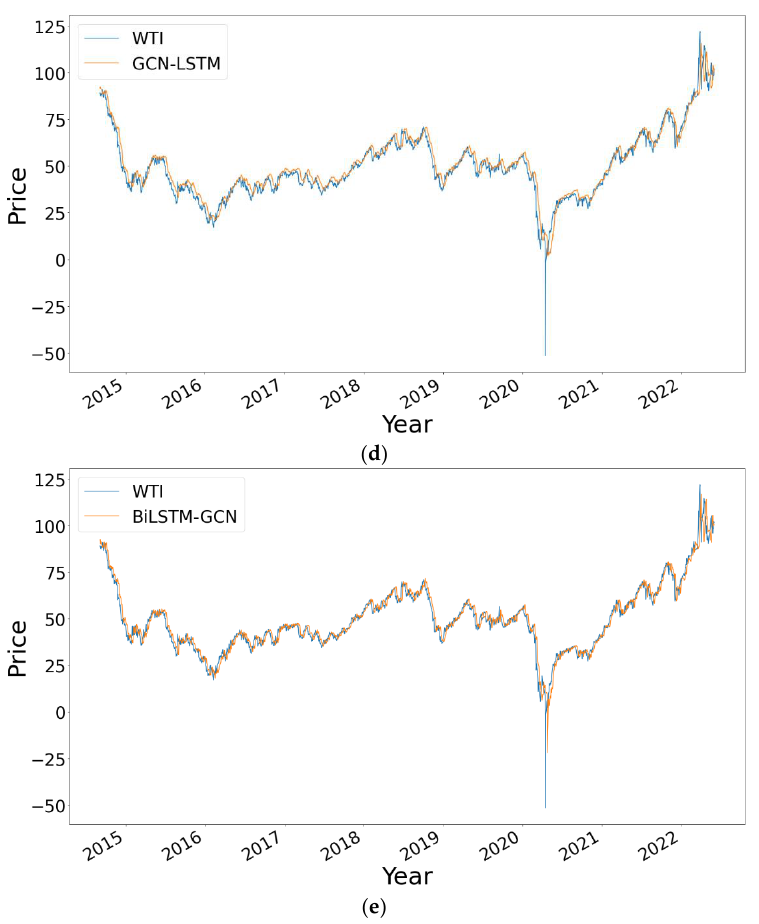
Figure 8. Results from the models: ( a ) ARIMA; ( b ) PROPHET; ( c ) BiLSTM; ( d ) GCN-LSTM; ( e ) BiLSTM-GCN.